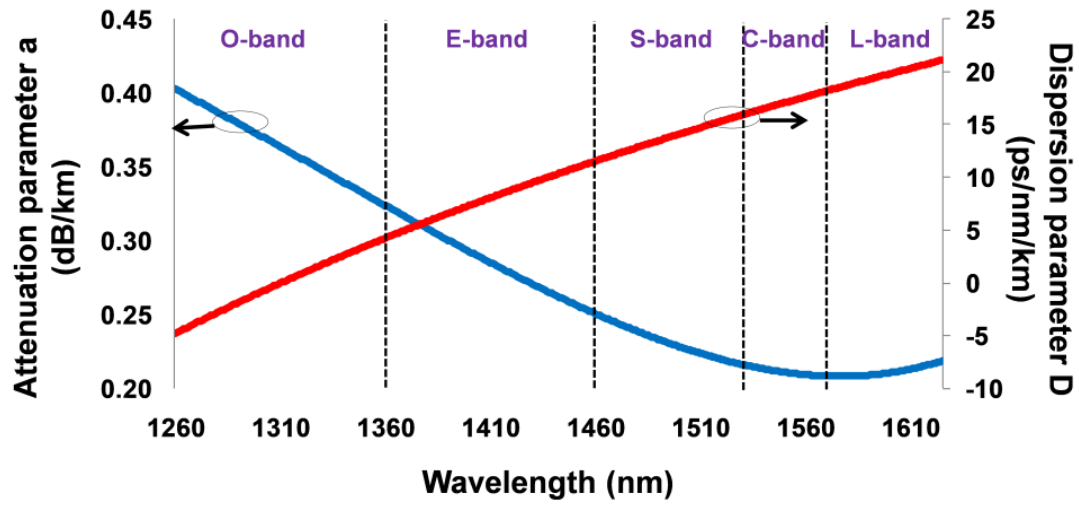
Figure 28. Attenuation and dispersion parameter of a G.652D fiber.